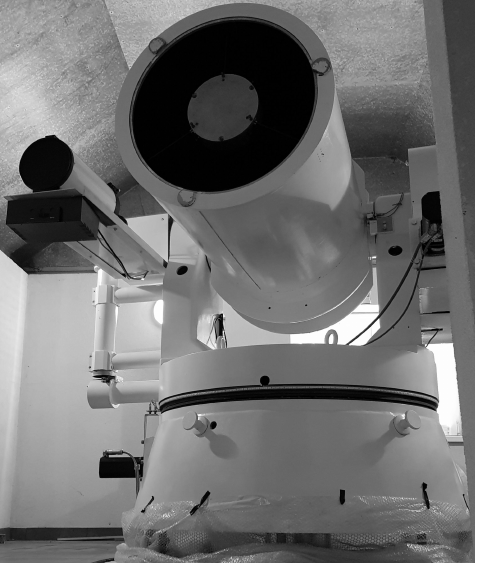
Figure 8. Cassegrain telescope in the Az / El configuration—hybrid laser